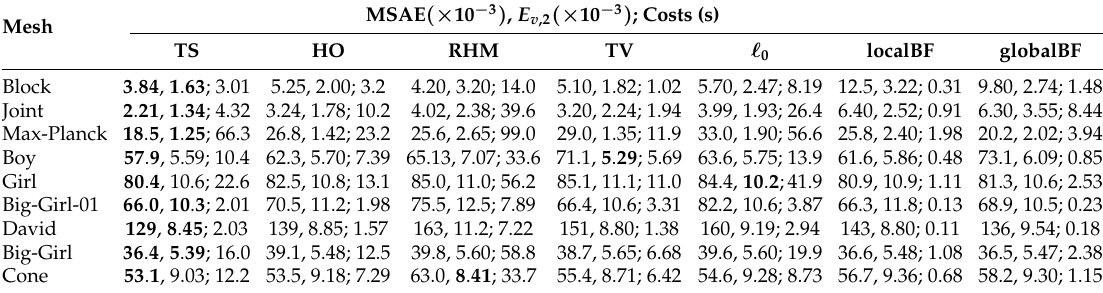
Table 1. Quantitative evaluation results of Figures 5–10 for all of the test methods.